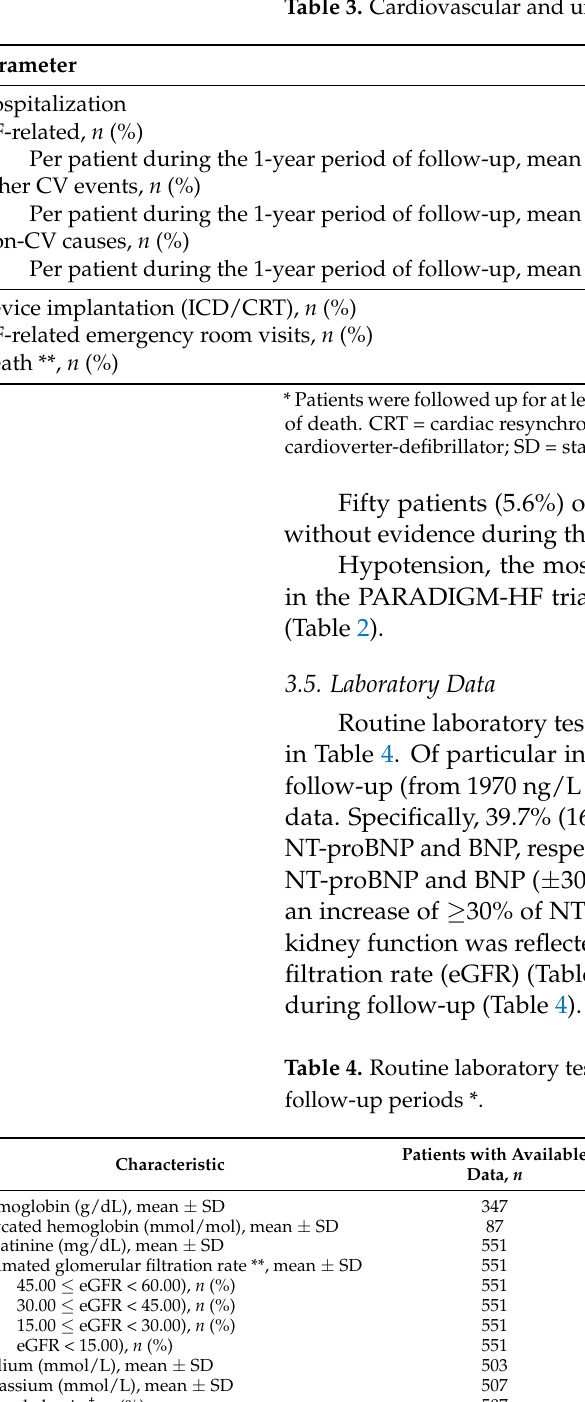
Table 3. Cardiovascular and unrelated events during follow-up *.